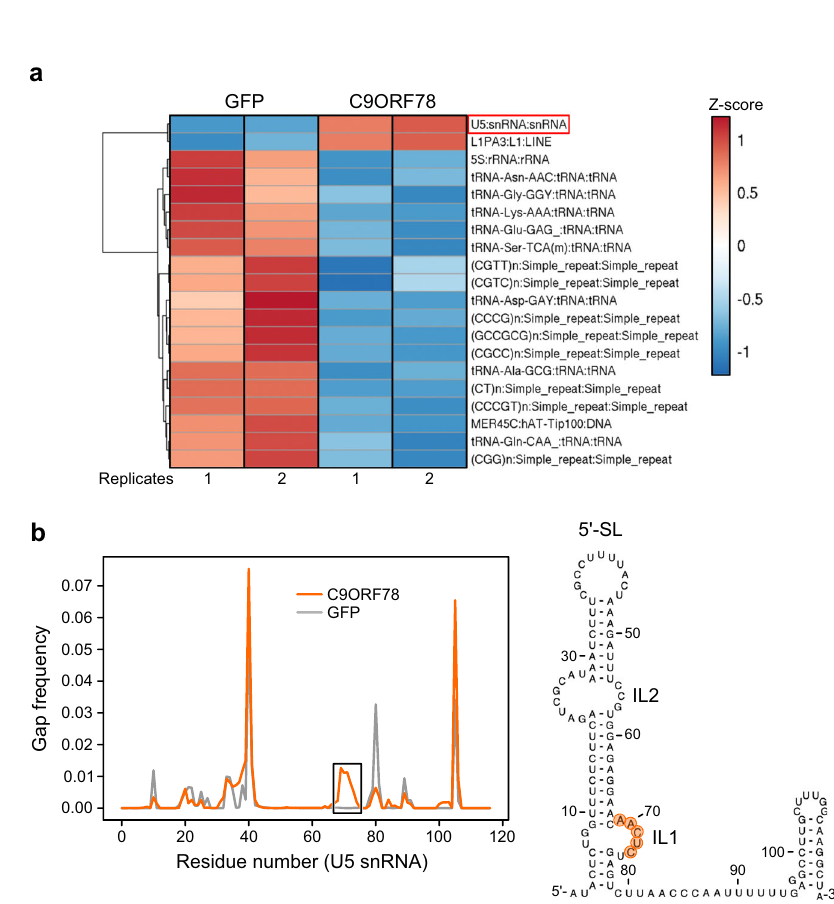
Fig. 5 Rescue of C9ORF78 KD-induced splicing changes. a Comparison of C9ORF78 KD-induced 3 ’ -ss changes detected in C9ORF78 KD experiments 1 (siRNA1, left) and 2 (siRNA2, right; Δ PSI > 0.15; p < 0.01). Numbers in each circle, affected events observed in the separate experiments. Number in the center, events observed in both experiments. Numbers in parentheses, signi fi cance of the observed overlaps determined by hypergeometric test. PSI, percent spliced-in (RNA-seq analysis), ratio of quanti fi ed junction reads representing exon inclusion to sum of quanti fi ed junction reads representing exon inclusion and exon skipping. b Box-whiskers plots for C9ORF78-induced 3 ′ -ss skipping events and rescue by siRNA-resistant C9ORF78 variants (based on second KD experiment including rescue; Δ PSI > 0.15; p < 0.01; n = 77 regulated alternative 3 ′ -ss). Horizontal lines, medians; whiskers, minimum and maximum values; boxes, upper and lower quartile. c Rescue of alternative 3 ′ -ss events by siRNA-resistant C9ORF78 variants (based on the second KD experiment that included rescue). Heat map, mean PSI values for 3 ′ -ss events signi fi cantly ( Δ PSI > 0.15; p < 0.01) and reproducibly altered upon C9ORF78 KD, showing that 3 ′ -ss changes are reverted similarly by C9ORF78 wt and C9ORF78 R41A . d Comparison of C9ORF78 KD-induced changes in exon skipping detected in C9ORF78 KD experiments 1 (siRNA1, left) and 2 (siRNA2, right; Δ PSI > 0.1; p < 0.05). Numbers as in a . e Box-whiskers plots for C9ORF78- induced cassette exon events (exon skipping, left, n = 205; exon inclusion, right, n = 271) and rescue by siRNA-resistant C9ORF78 variants (based on second KD experiment including rescue; Δ PSI > 0.15; p < 0.01). Symbols as in b . f Rescue of alternative exon events by siRNA-resistant C9ORF78 variants. Heat map, alternative exon events (log2-fold-change relative to control) signi fi cantly ( Δ PSI > 0.1; p < 0.05) and reproducibly altered upon C9ORF78 KD, showing that these events are speci fi cally reverted by C9ORF78 wt ( Δ PSI > 0.1; p < 0.05) but not by C9ORF78 R41A ( Δ PSI < 0.01; p > 0.01; n = 49 target exons). PTBP2 exon 10, highlighted on the left. g Effect of C9ORF78 KD on PTBP2 exon 10 splicing and differential rescue by siRNA-resistant C9ORF78 variants. PSI values (mean ± SEM) were determined by rMATS. Statistical signi fi cance is based on rMATS-derived p-values (* p < 0.05; ns, not signi fi cant; si control vs. si C9ORF78, p = 0.03; si control vs. wt, p = 0.47; si control vs. rescue R41A, p = 0.01; n = 3 biologically independent experiments). Source data for b , d and g are provided as a Source Data fi le.